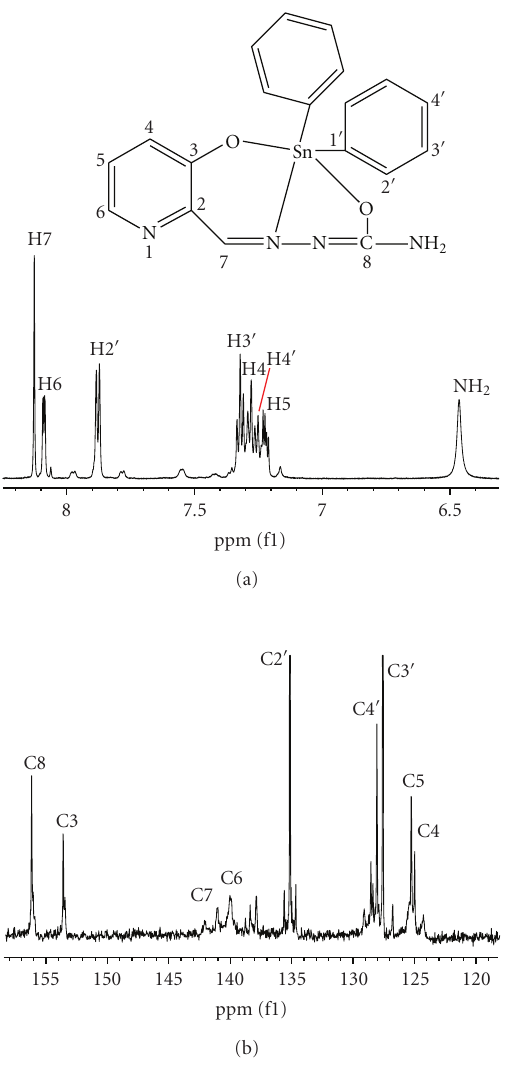
Figure 4: 1 H NMR (a) and 13 C NMR (b) spectrum of the complex ( 2